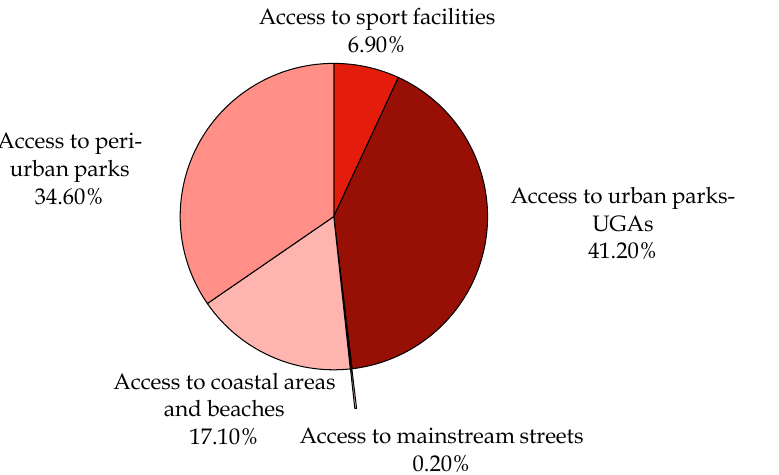
Figure 13. Responses on the preference of services that citizens prefer to be available to the wider public in case of lockdown measures against the spread of COVID-19 (research question: “In case of restriction measures (quarantine) to help minimize the spread of COVID-19, which of the following services would you choose to be available for the general public